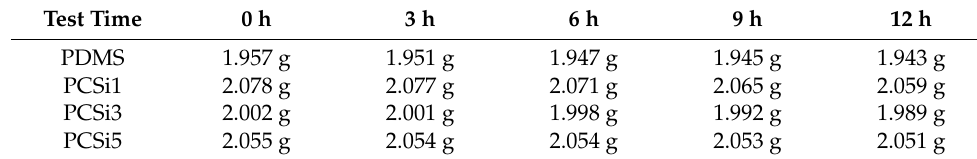
Table 4. Mass of samples after erosion.